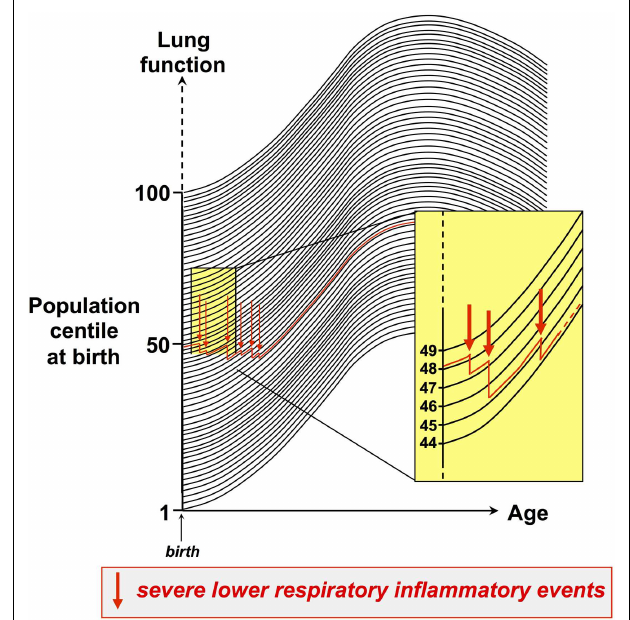
FIGURE 1 | Establishing trajectories for maturation of respiratory function during childhood . Respiratory function can be expressed as population centiles, and during the preschool years individual children typically track on the same respiratory function centile (dark lines) defined by their personal centile at birth. Experiencing recurrent inflammatory events of sufficient intensity and duration to perturb ongoing growth/differentiation of lung tissues can result in non-reversible tissue remodeling, accompanied by stepwise dropping to progressively lower levels of lung function.The figure exemplifies an infant who is in the 49th centile at birth, who after three such severe events has declined to the 44th